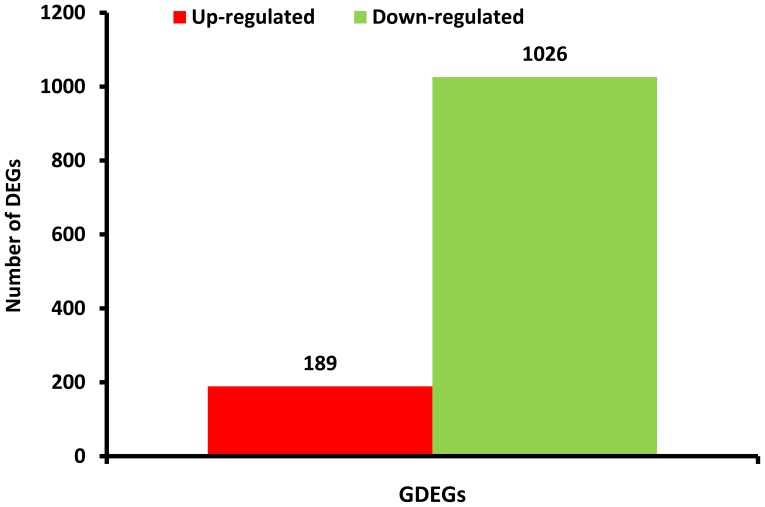
Summary of differently expressed genes in each pariwise comparison.GDEGs: Gradient differentially expressed genes, HZA-VS-SS.LZA-VS-SS. GXA-VS-SS